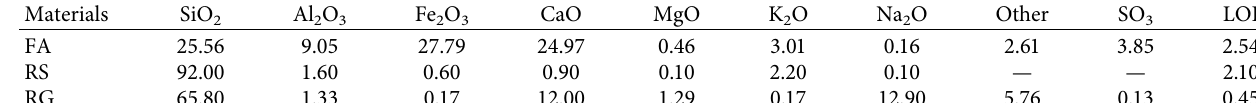
Table 1: Chemical compositions of FA, RS, and RG (by % weight).